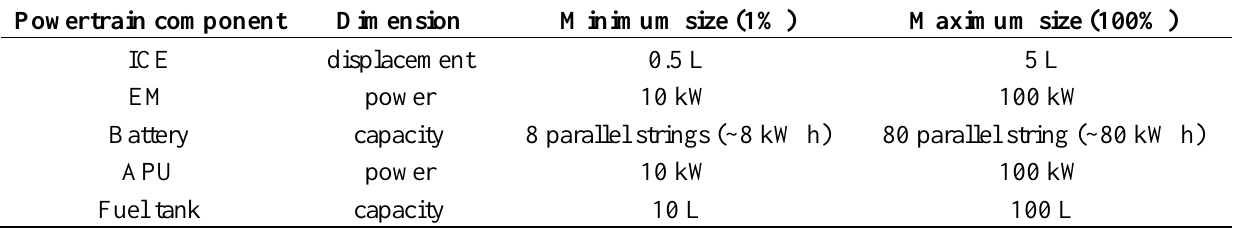
Table 5. Normalization of powertrain component sizes for